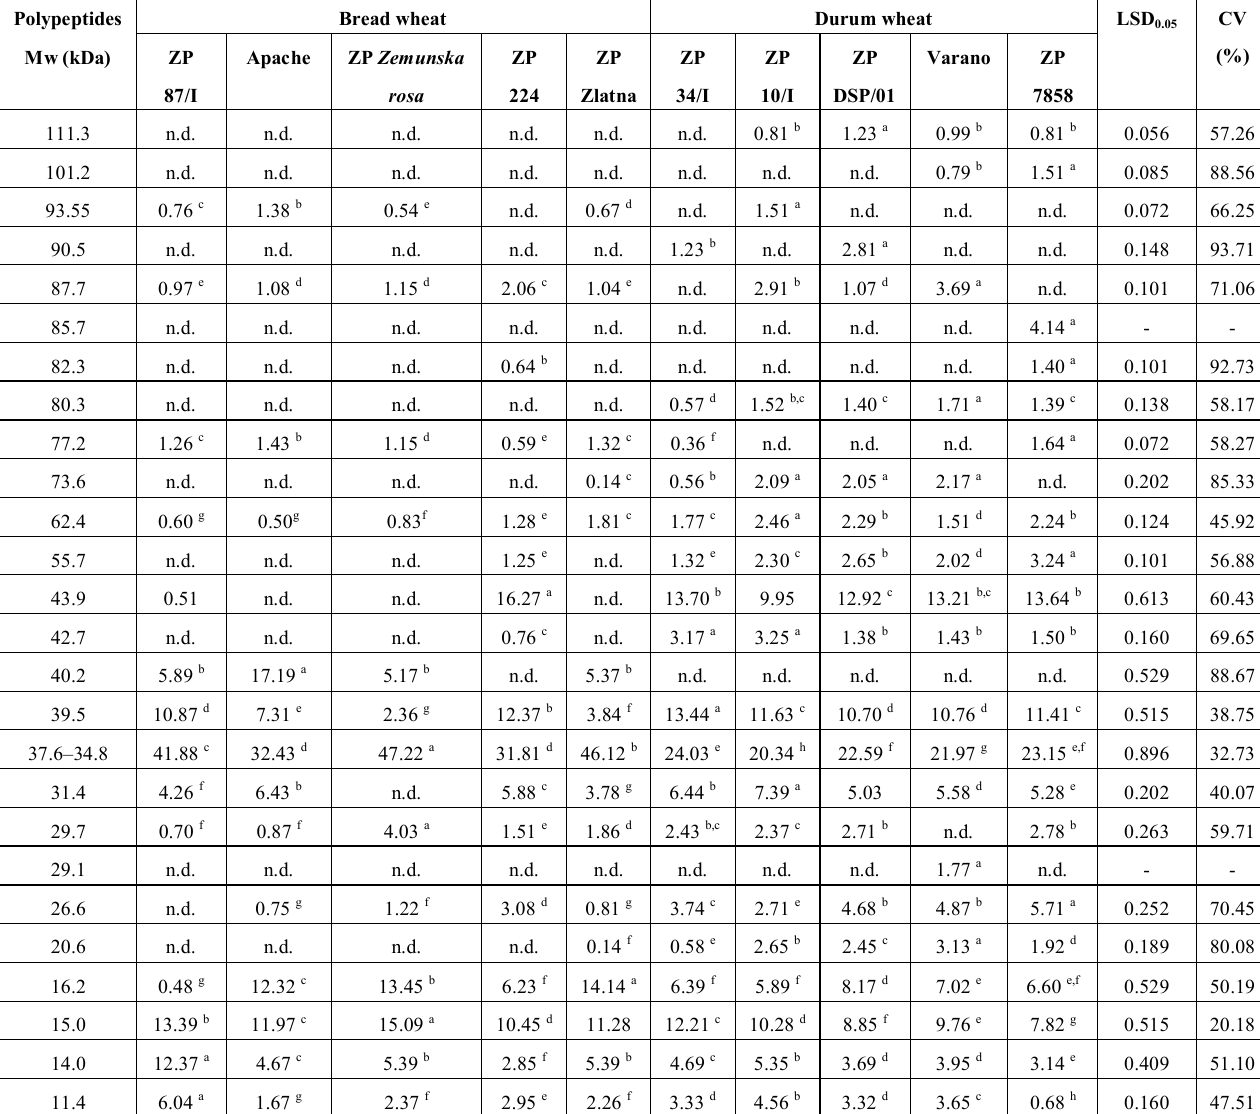
Mean of genotypes followed by the same letter within same row are not significantly different according to the least significant difference (LSD) ( P < 0.05); CV, coefficient of variation; n.d.—not